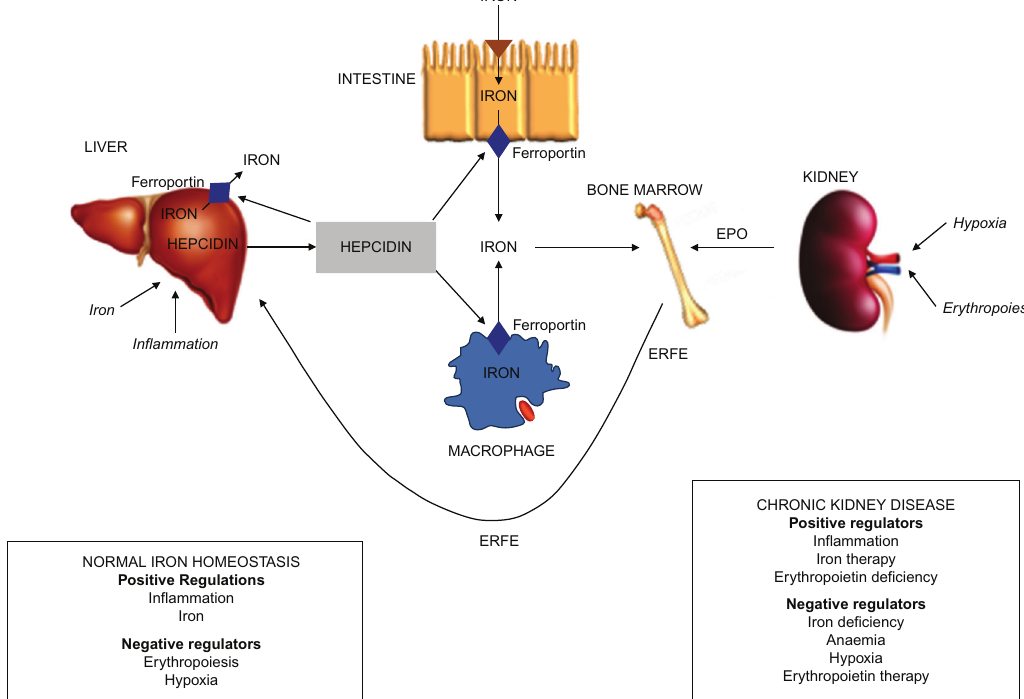
Figure 1. Schematic representation of the role of hepcidin in iron metabolism in health and in chronic kidney disease (CKD). Both iron and erythropoietin (EPO) are required for the production of red blood cells in the bone marrow. Hepcidin regulates iron absorp- tion from the intestine, macrophage iron recycling from senescent red blood cells and iron release from the liver via ferroportin, the iron transport protein. Hepcidin causes degradation of ferroportin leading to cellular iron retention and decreased absorption of ingested iron. Several factors including iron and in fl ammation act directly on the liver to up-regulate hepcidin production. Erythro- poiesis and hypoxia negatively regulate hepcidin production indirectly, by increasing EPO production by the kidneys. This stimulates synthesis of erythroferrone (ERFE) by the bone marrow, which in turn controls liver hepcidin production. In CKD, anaemia occurs due to reduced EPO production from the kidneys and from reduced iron absorption and availability, the latter resulting from elevated levels of hepcidin. In CKD, hepcidin levels are raised due to the combination of increased in fl ammation, decreased EPO levels and reduced renal clearance. EPO therapy decreases hepcidin levels leading to iron mobilisation from body stores during erythropoiesis.